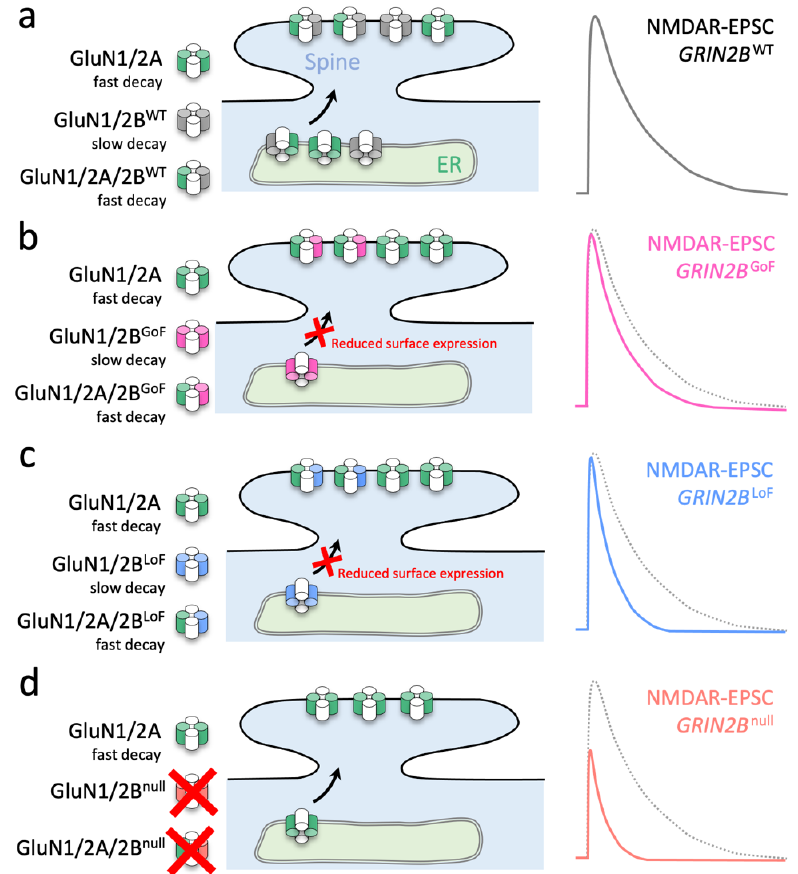
Figure 7. Scheme summarizing how different molecular defects in the agonist binding domain of GluN2B converge to accelerate NMDA-EPSCs in CA1 neurons. ( a ) Schaffer collateral synapses onto CA1 neurons contain triheteromeric receptors (GluN1/2A/2B) and a small population of diheteromeric receptors (GluN1/2A and GluN1/2B). ( b ) GoF missense mutations in GluN2B cause GluN1/2B receptors to have more prolonged decay (Figure 1b,e), but do not traffic effectively to synapses (Figure 1b,c). Synaptic GluN1/2A/2B receptors with GoF GluN2B mutations traffic comparatively better than their GluN1/2B counterparts (Figure 2a), but the NMDA-EPSC time course is accelerated owing to the dominance of GluN2A on the deactivation of triheteromeric NMDA receptors (Figure 4b). ( c ) LoF missense mutations (that strongly reduce GluN2B surface expression) lead to an absence of mutant GluN1/2B receptors (Figure 1b,c), and likely also a greater representation of GluN1/2A receptors at synapses (Figure 2a). ( d ) Genetic deletion (i.e., the null allele) of Grin2b prevents the formation of NMDA receptors with any GluN2B subunits.